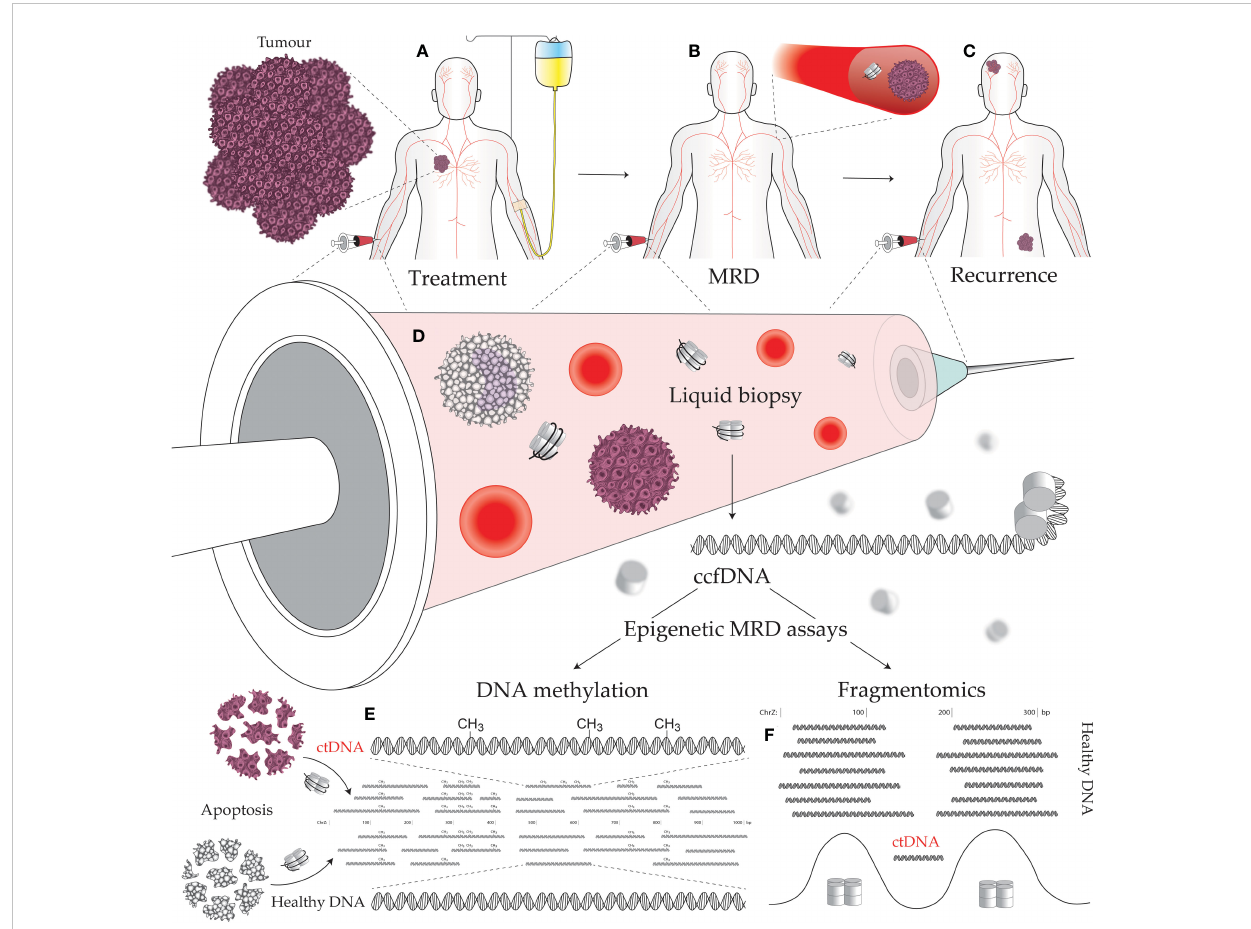
FIGURE 1 Minimal residual disease (MRD) epigenetic assays and their use across a cancer patient journey. (A) Establishing the molecular targets for MRD assays can be performed prior to treatment initiation. A decline in the level of the assayed biomarker suggests ef fi cacious treatment and reduced tumor burden. (B) The continued presence of a tumor biomarker after curative intent treatment, accompanied by no visible signs of a tumor, indicates the presence of MRD. (C) Tracking with an MRD assay over time is useful for early detection of cancer recurrence, as the level of the assayed biomarker will increase as a tumor remerges. (D) Liquid biopsies can be performed on a variety of bodily fl uids including blood, urine, saliva, lymph, and cerebrospinal fl uid. Circulating tumor DNA (ctDNA) contains epigenetic alterations that can separate it from the cancer ’ s normal tissue counterpart and circulating